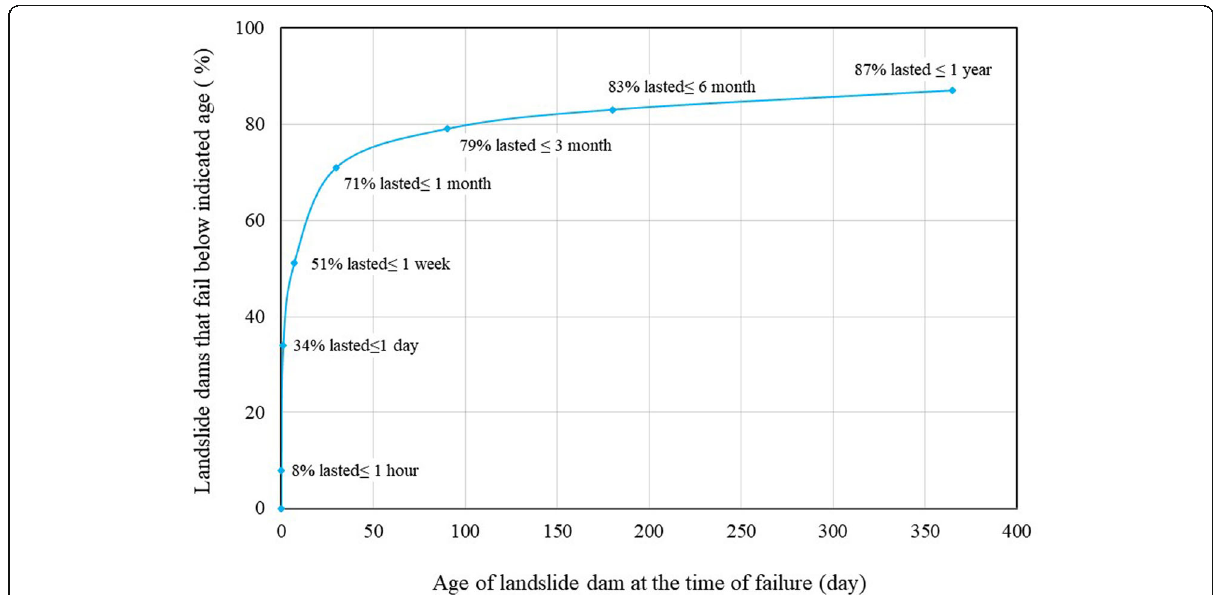
Fig. 1 Age of landslide dam at the time of failure (240 cases) (Peng and Zhan